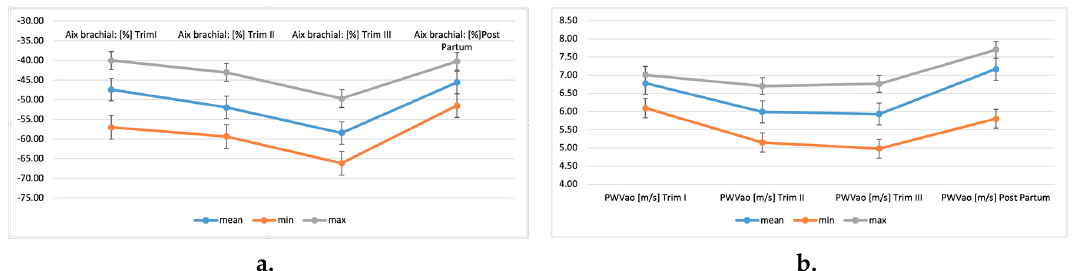
Figure 2. The brachial AIx ( a ) and PWVao progressions ( b ), in group 1 (healthy pregnant patients, N1 = 471).